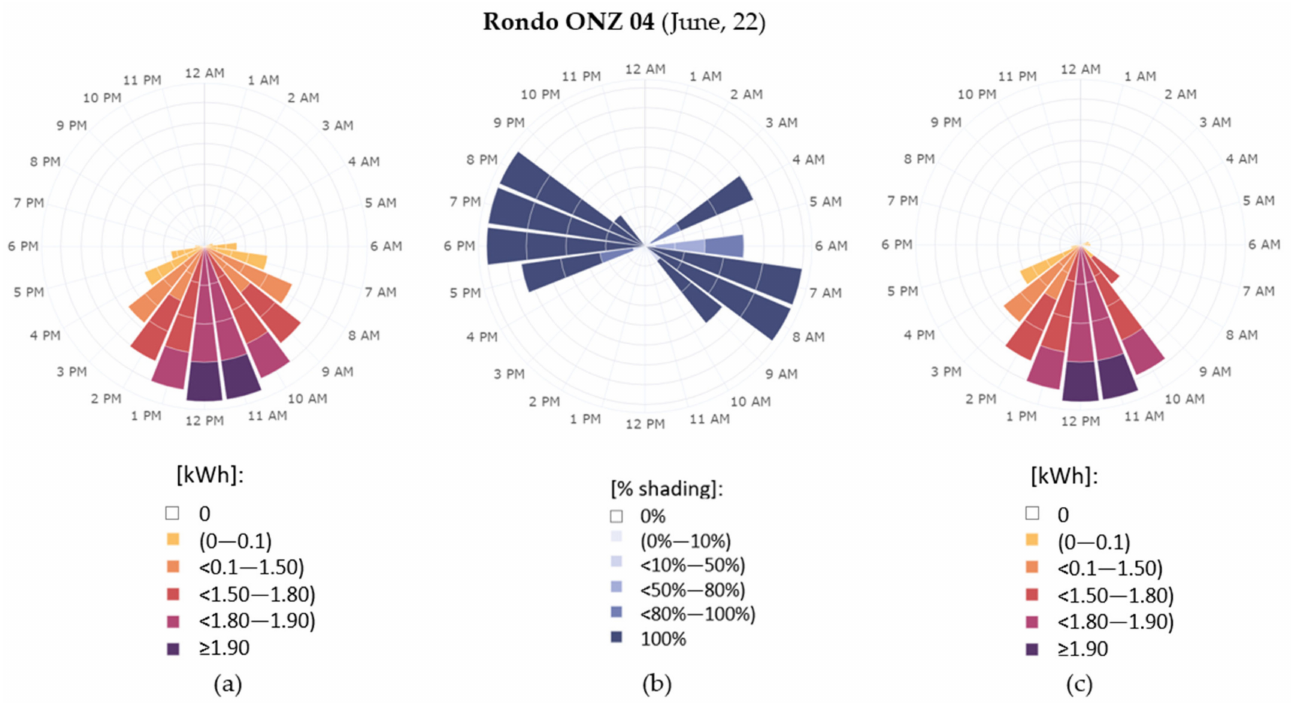
Figure 24. Results obtained for the shelter roof in the neighbourhood of Dworzec Centralny 08 tram stop for 22 December 2020: ( a ) solar potential in kWh per stop shelter roof area; ( b ) percentage loss due to shelter shading; ( c ) actual solar potential including shading (kWh) per stop shelter roof area. The maximum value is about 0.38 kWh (1.37 MJ).